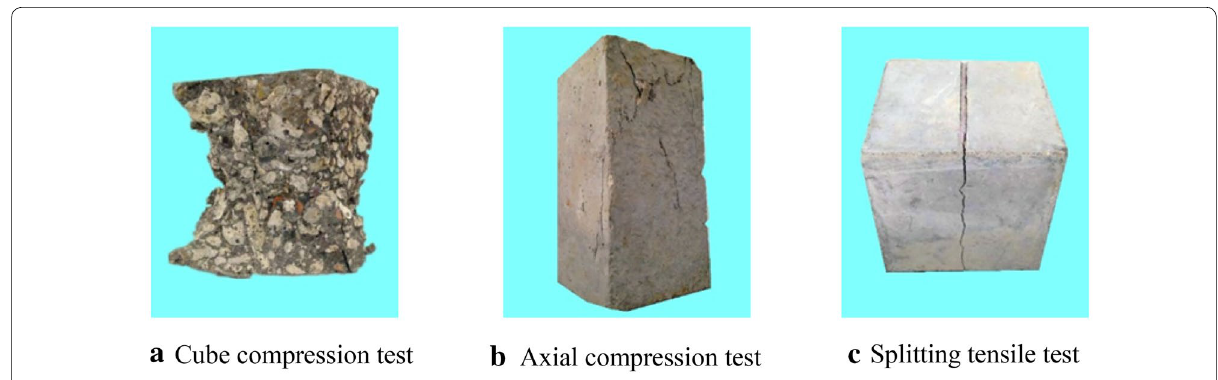
Fig. 4 Failure modes of coral